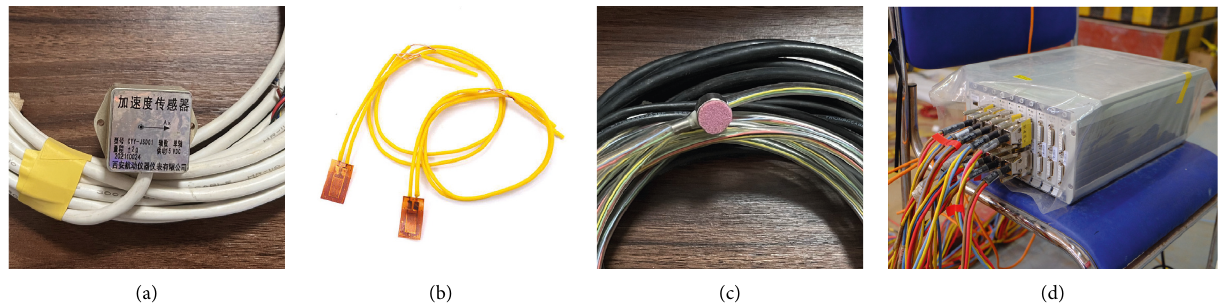
Figure 3: Sensors and data acquisition system. (a) Acceleration sensor (model: CYY-JSD01). (b) Strain sensor. (c) Pore water pressure sensor (model: CYY2). (d) Data acquisition system (model: